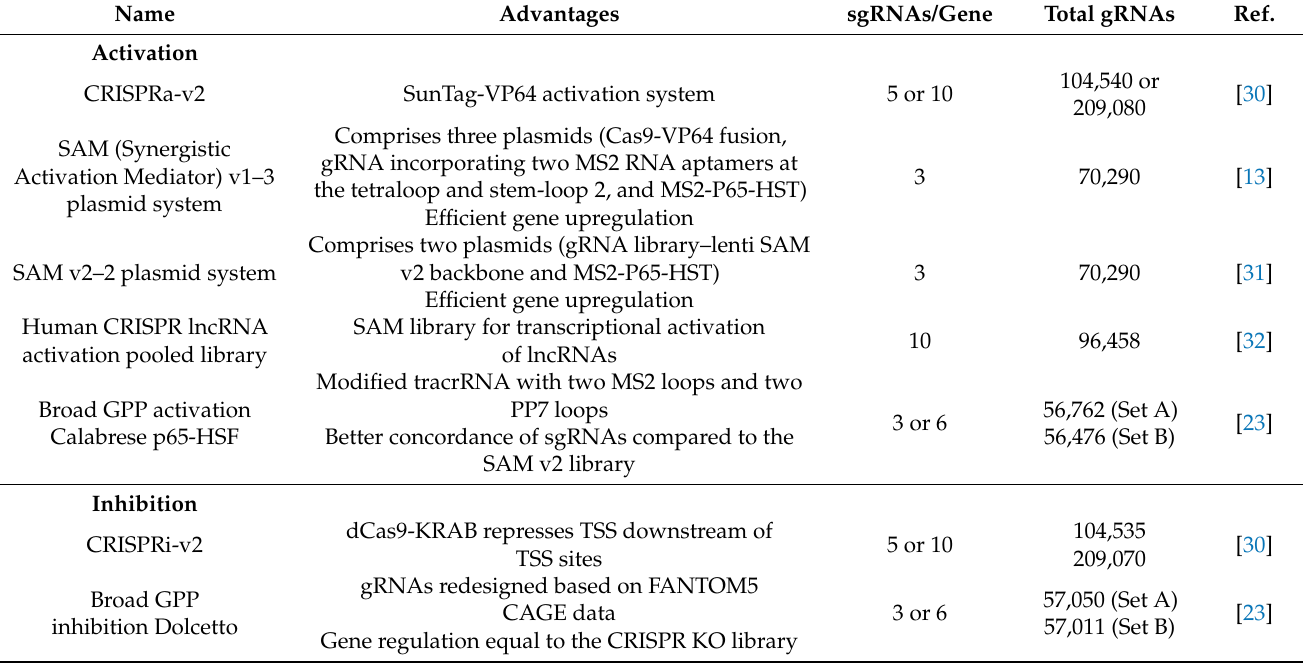
Table 2. CRISPR activation and inhibition